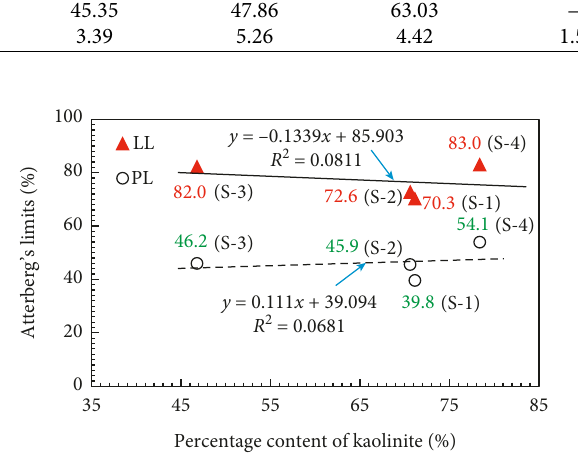
Figure 5: Relationships between kaolinite content and Atterbeg’s limits of lateritic clay.